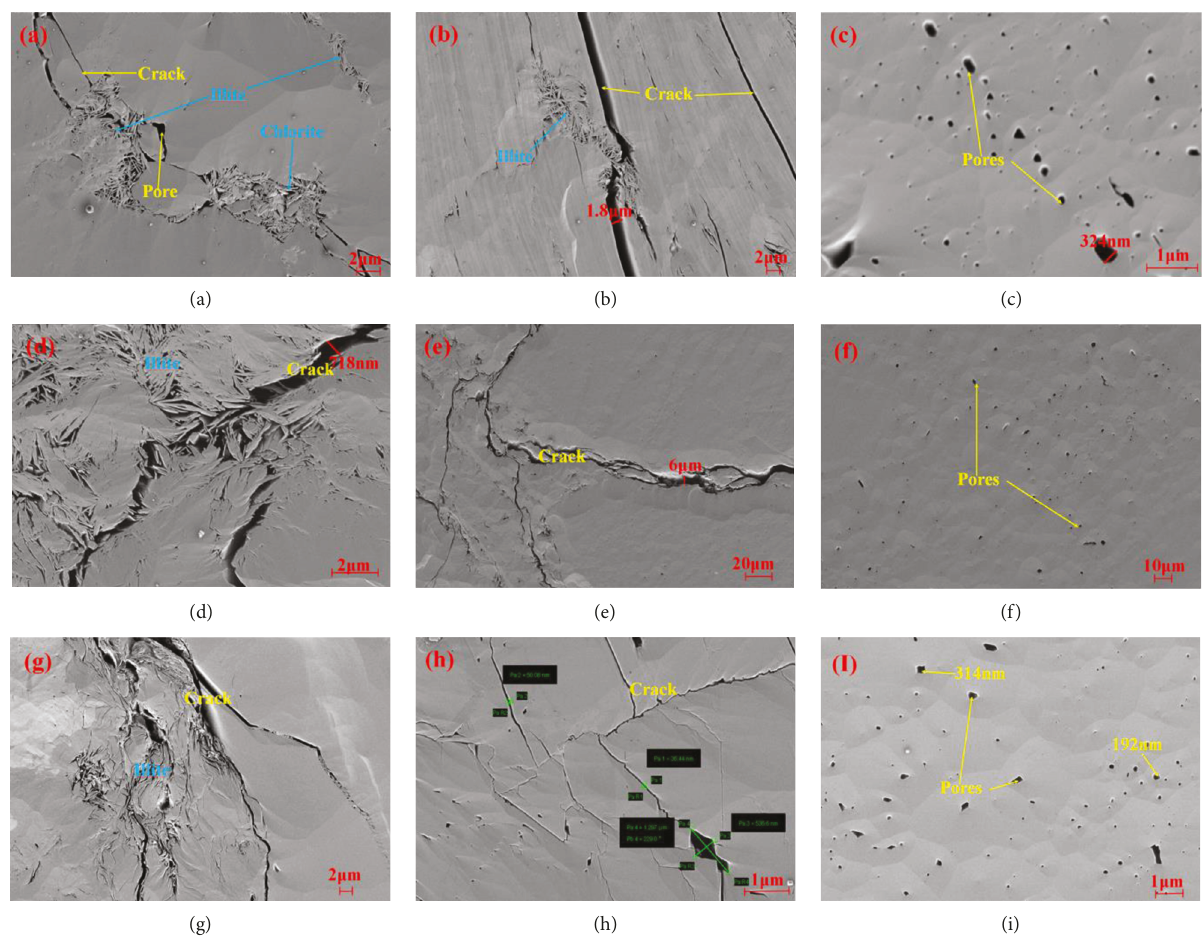
Figure 8: The SEM picture: (a) – (c) belong to S30-2, (d) – (f) belong to S120-1, and (g) – (i) belong to